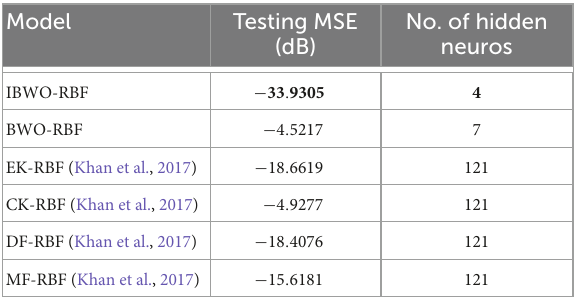
TABLE 6 Comparison of six models for the approximation of nonlinear function.